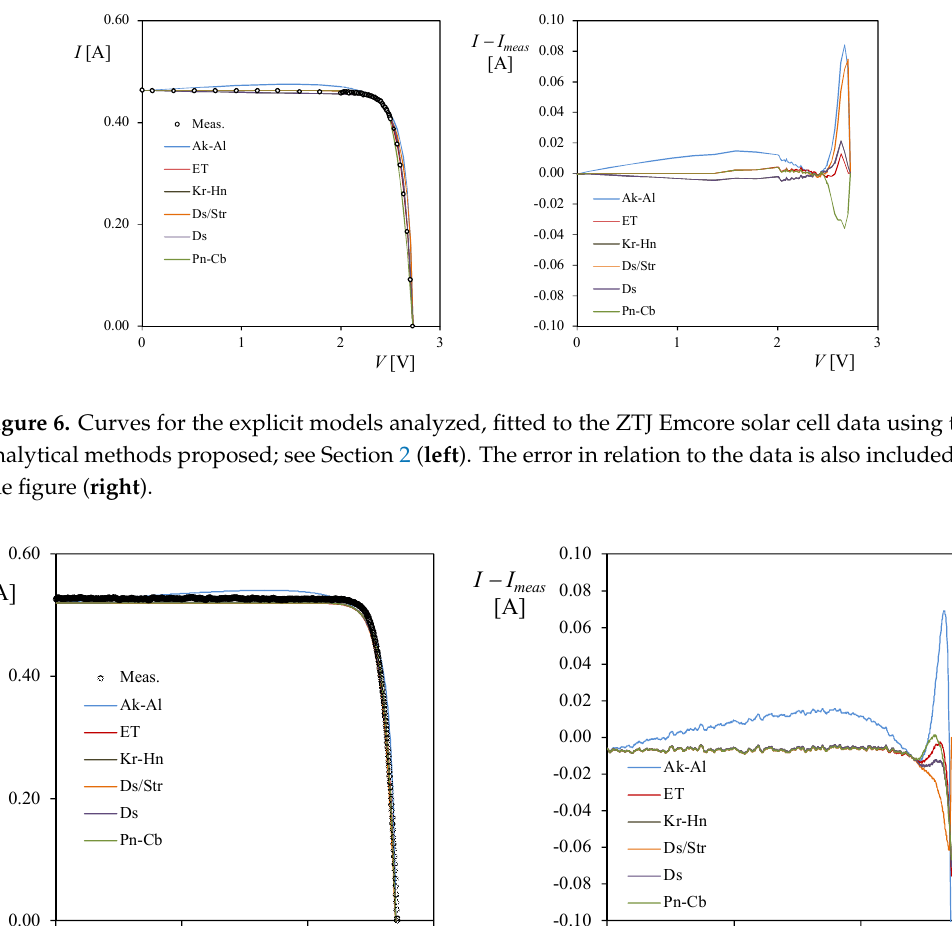
Figure 8. Curves for the explicit models analyzed, fitted to the Photowatt PWP 201 solar panel data using the analytical methods proposed; see Section 2 ( left ). The error in relation to the data is also included in the figure ( right ).